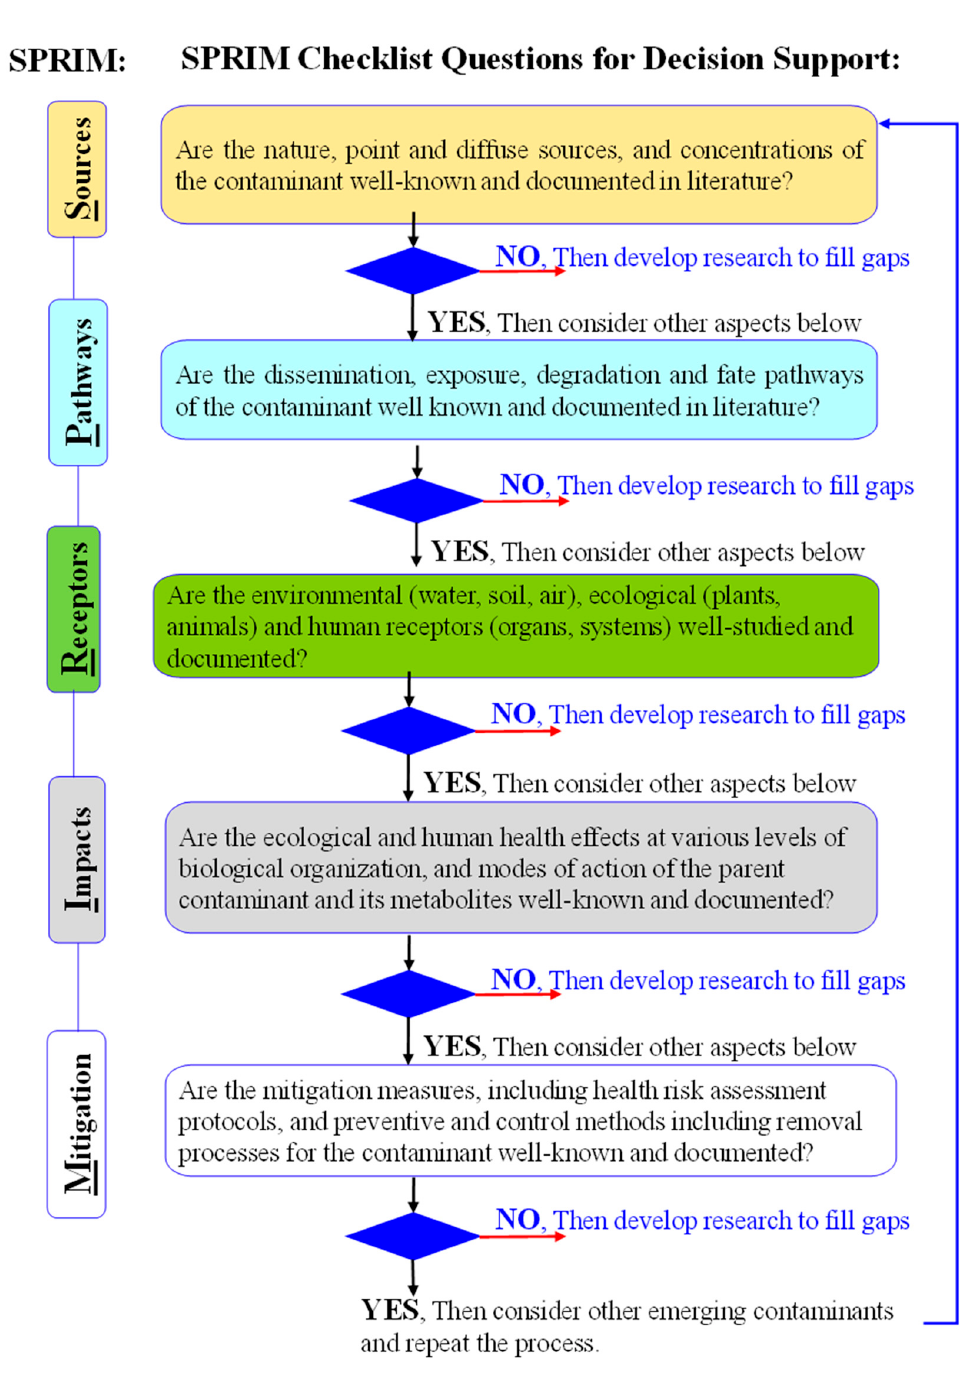
Figure 2. A flow-chart depicting the Source–Pathway–Receptor–Impact–Mitigation (SPRIM) contin- uum framework as a decision-support tool to frame research on emerging